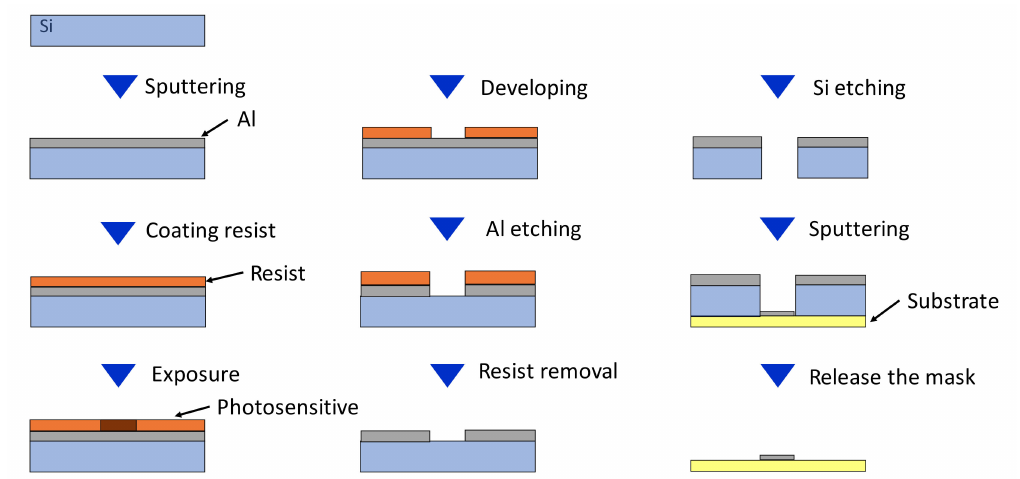
Figure 14. Circuit fabrication method by semiconductor microfabrication